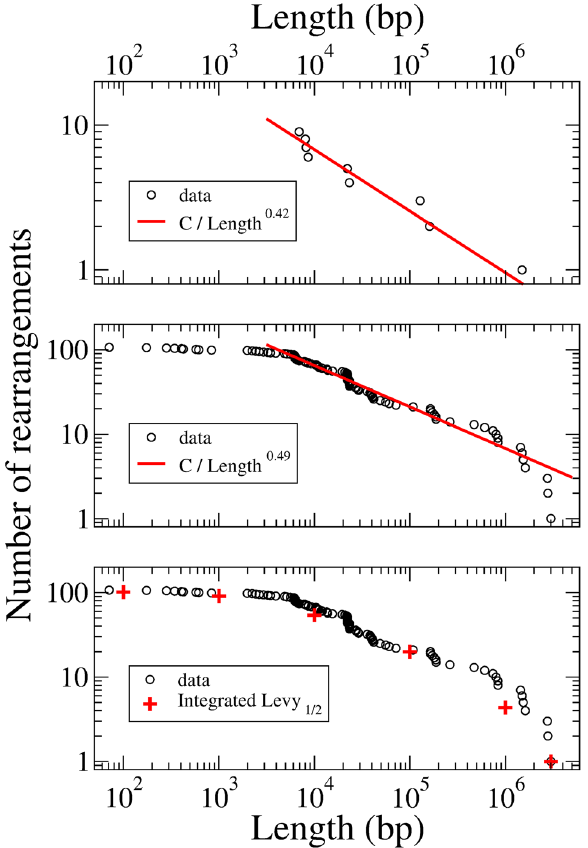
Figure 3. Top: Log-log plot of the integrated size distribution function of large (greater than 5 Kbp) chromosomal rearrangements in clones of the Ara-1 population. The red line is a fit with a 1 / l ν dependence. Center: log–log plot of the integrated size distribution of large rearrangements in clones obtained from the 12 independently evolving populations in the LTEE, sampled at generation 40,000. The red line is a fit with the 3 < l < 1.7 × 10 6 function 1 / l ν for l in the interval 5 × 10 . Bottom: A fit to the observed distribution in a wider interval by means of the integral Levy 1/2 distribution given in Eq.